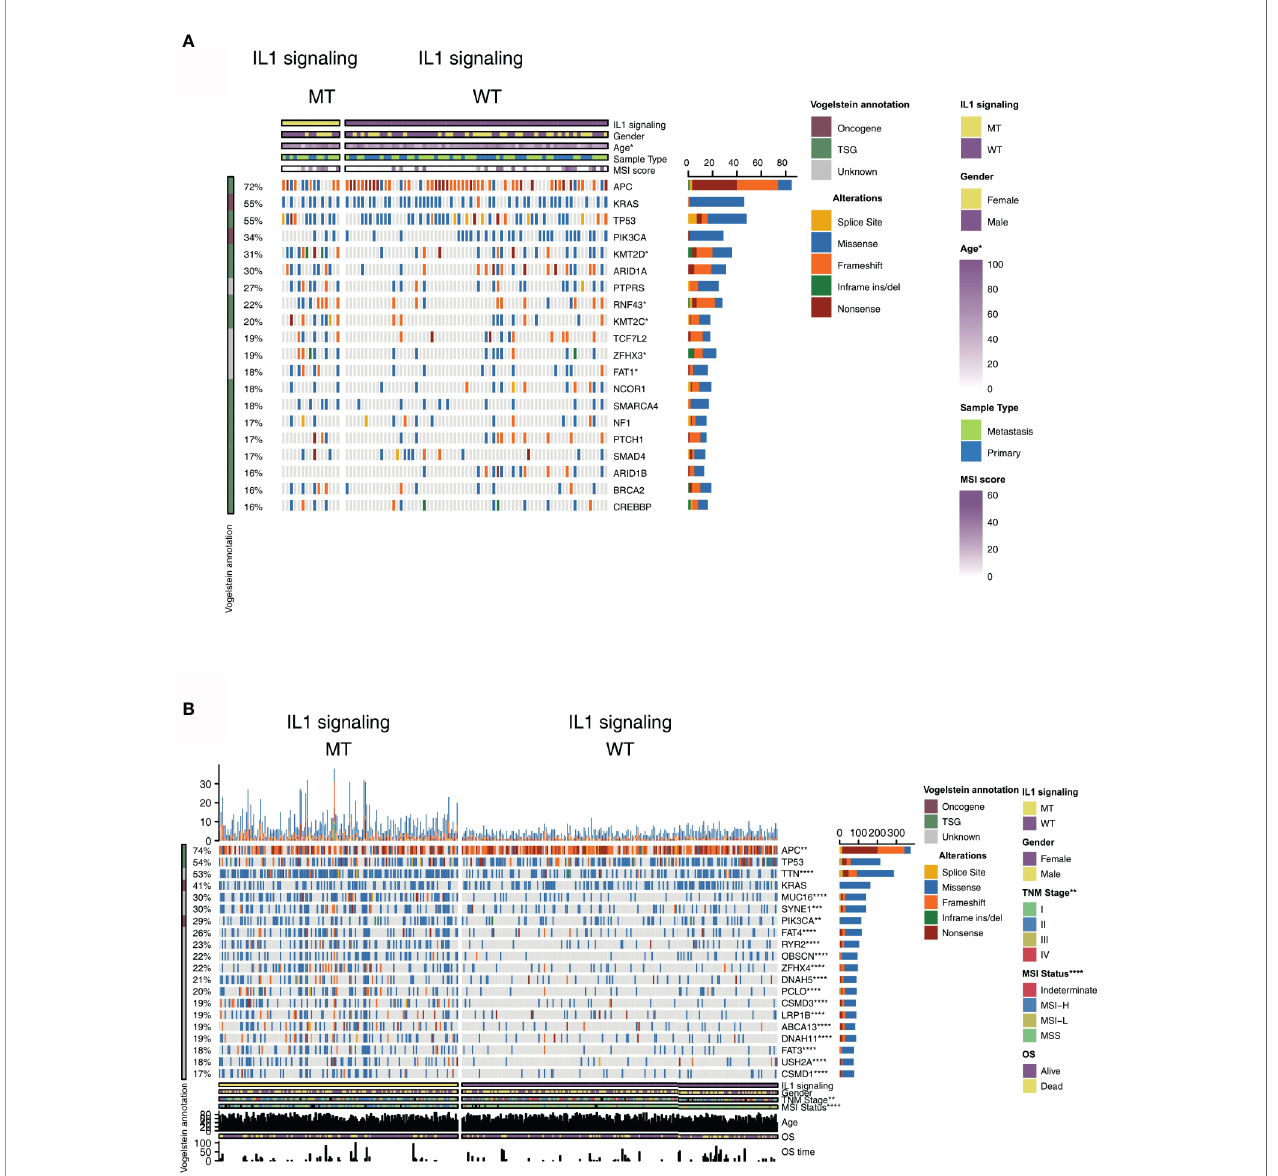
FIGURE 2 | Genomic pro fi les of COAD patients in the ICI-treated (A) and TCGA-COAD (B) cohorts. The top 20 genes with the highest mutation frequencies and the corresponding clinical information are shown in the fi gure. The top fi ve genes with the highest mutation frequencies in the ICI-treated cohort were APC (72%), KRAS (55%), TP53 (55%), PIK3CA (34%) and KMT2D (31%). The top fi ve genes with the highest mutation frequencies in the TCGA-COAD cohort were APC (74%), TP53 (54%), TTN (53%), KRAS (41%) and MUC16 (30%). For the mutation type, yellow indicates splice site mutations, blue indicates missense mutations, orange indicates frameshift mutations, green indicates inframe indel mutations and brown indicates nonsense mutations. The IL-1 signaling mutation status, sex, age, sample type and MSI score are shown as patient annotations (the upper/lower bar plot). The left bar plot marks the mutation rate of each gene. (*P < 0.05, **P < 0.01, ***P < 0.001 and ****P < 0.0001; Fisher ’ s exact